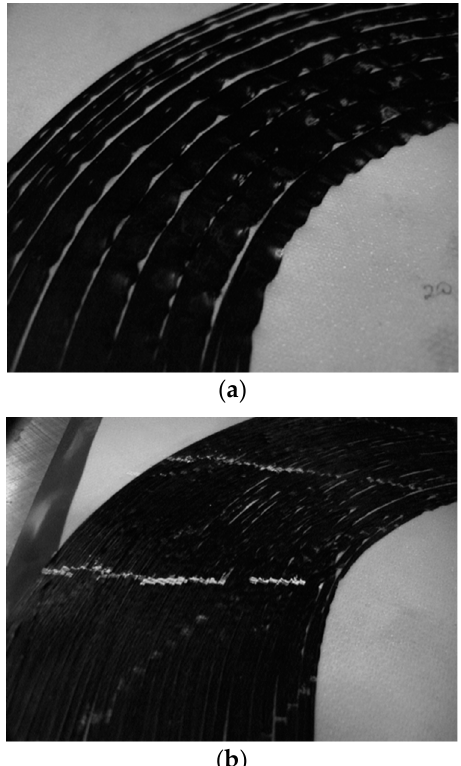
Figure 8. The laying circle using one-piece and multi-piece compaction rollers. ( a ) Laying circle us- ing one-piece compaction roller. ( b ) Laying circle using multi-piece compaction